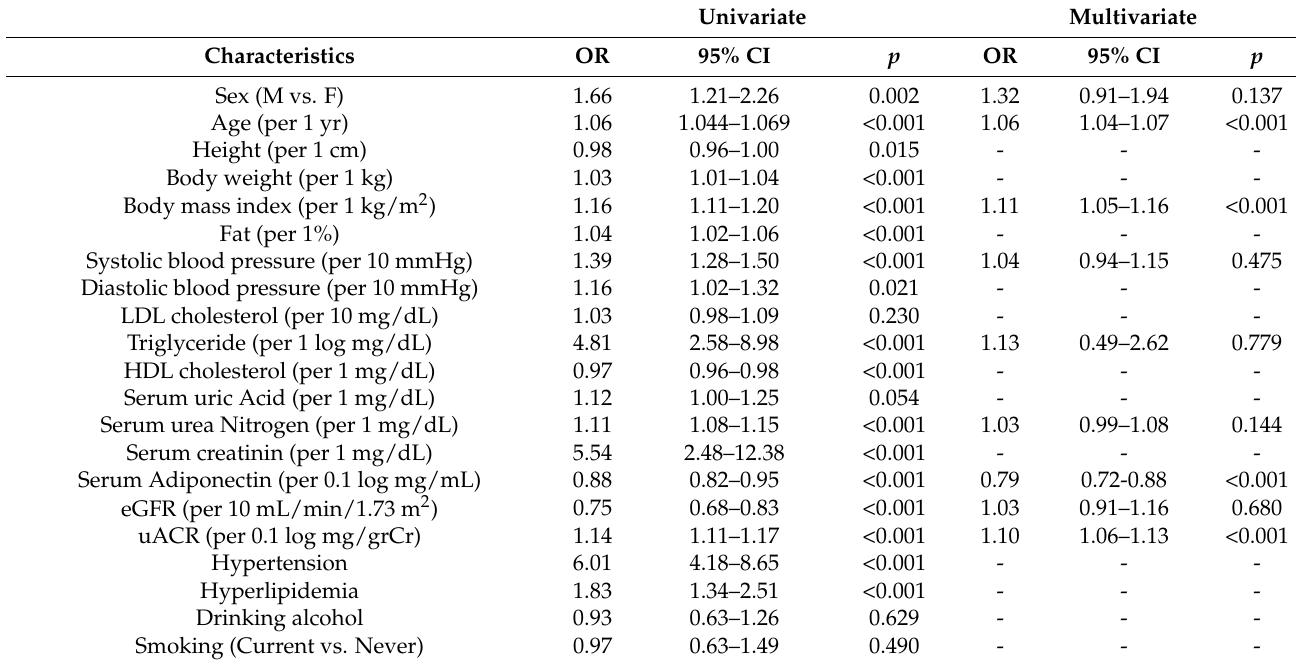
Table 2. Factors correlated with type 2 diabetes.